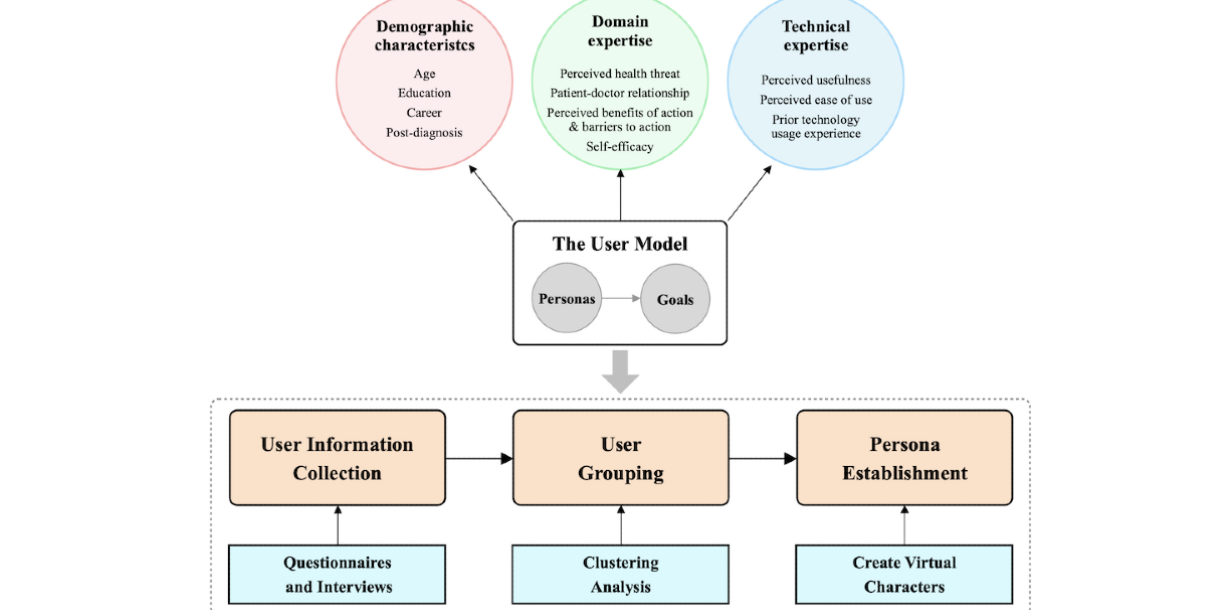
Figure 3. Specified user model for improving compliance with hypertension self-management and the concrete user modeling